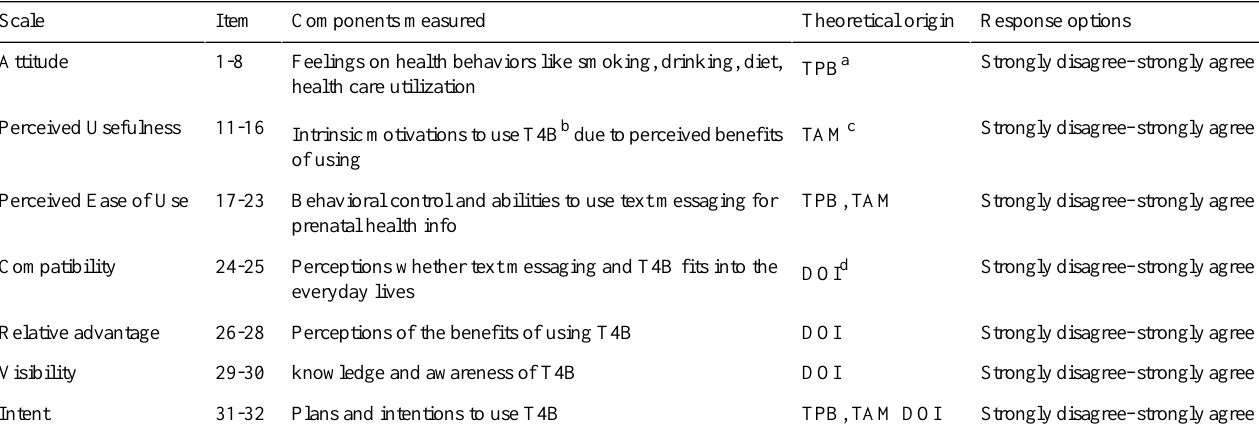
Table 1. Questionnaire components by scale.